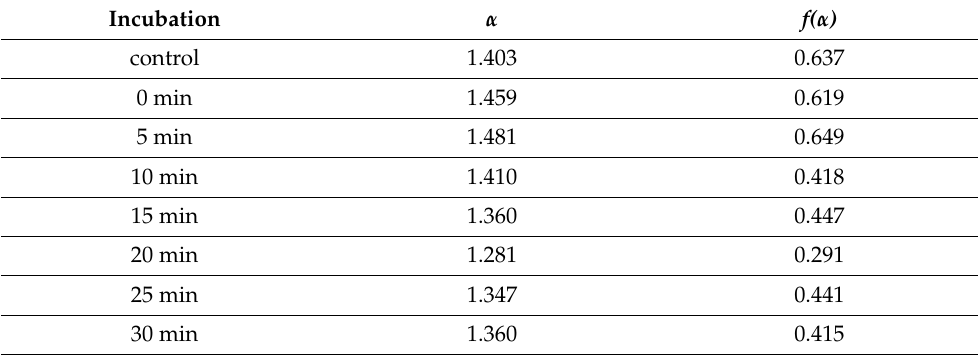
Table 2. The left-hand side final points coordinates of the singularity spectrum curves for the different incubation times in IAA solution and the control bath. U = − 100 mV.